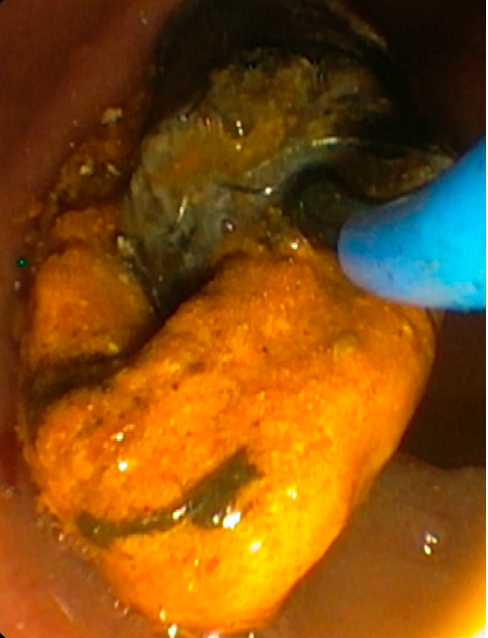
Figure 6. Endoscopic intervention for occluded self-expandable metal stent; sludge removal with a Fogarty balloon.